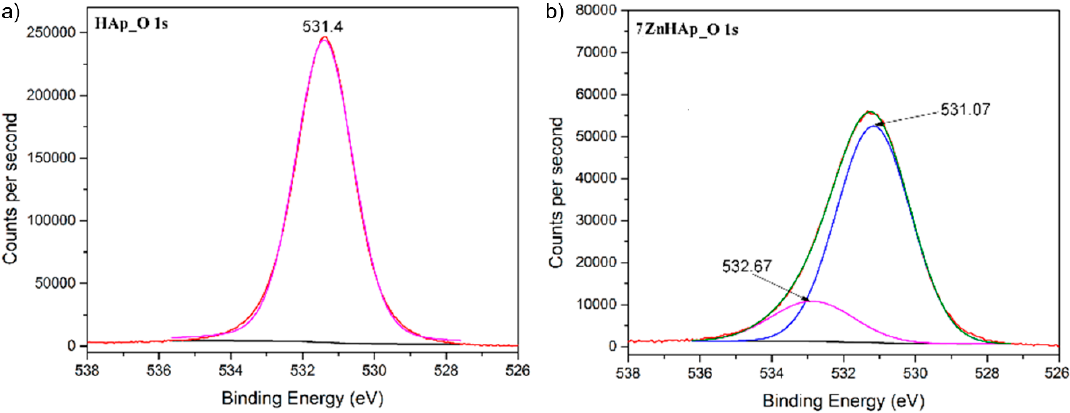
Figure 4. The high-resolution XPS spectra for O 1s of HAp ( a ) and 7ZnHAp ( b ) samples.